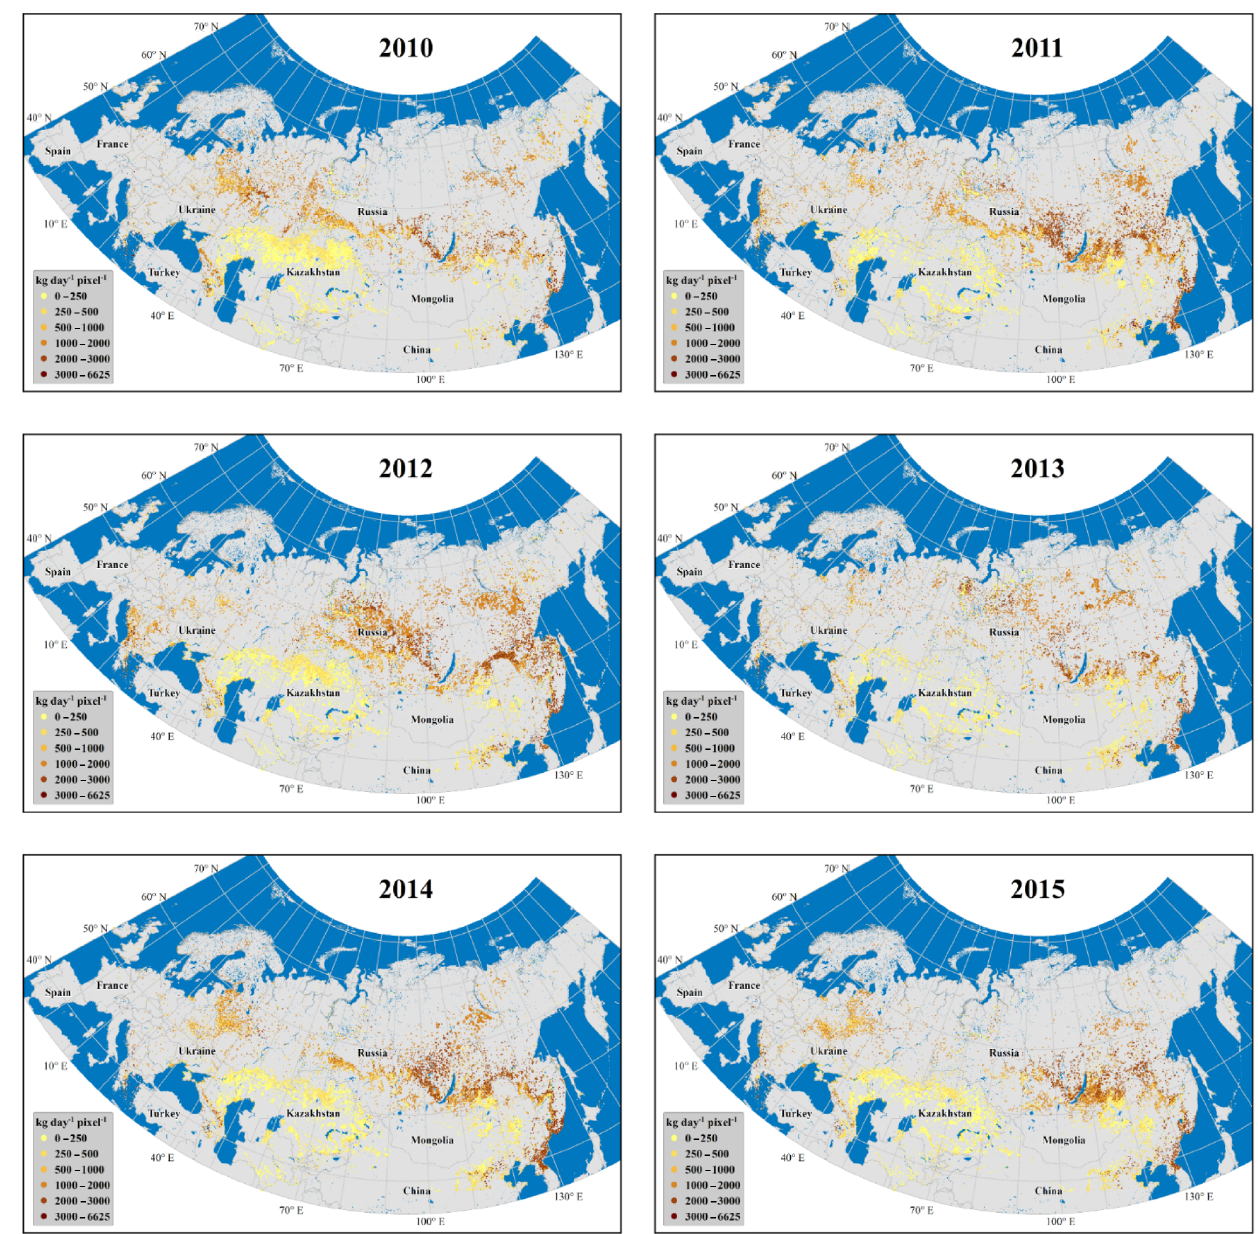
Figure 5. Daily BC emissions in northern Eurasia at a 500m × 500m resolution from 2002 to